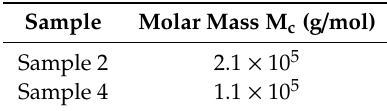
Table 4. Molar mass Mc of crosslinked samples.